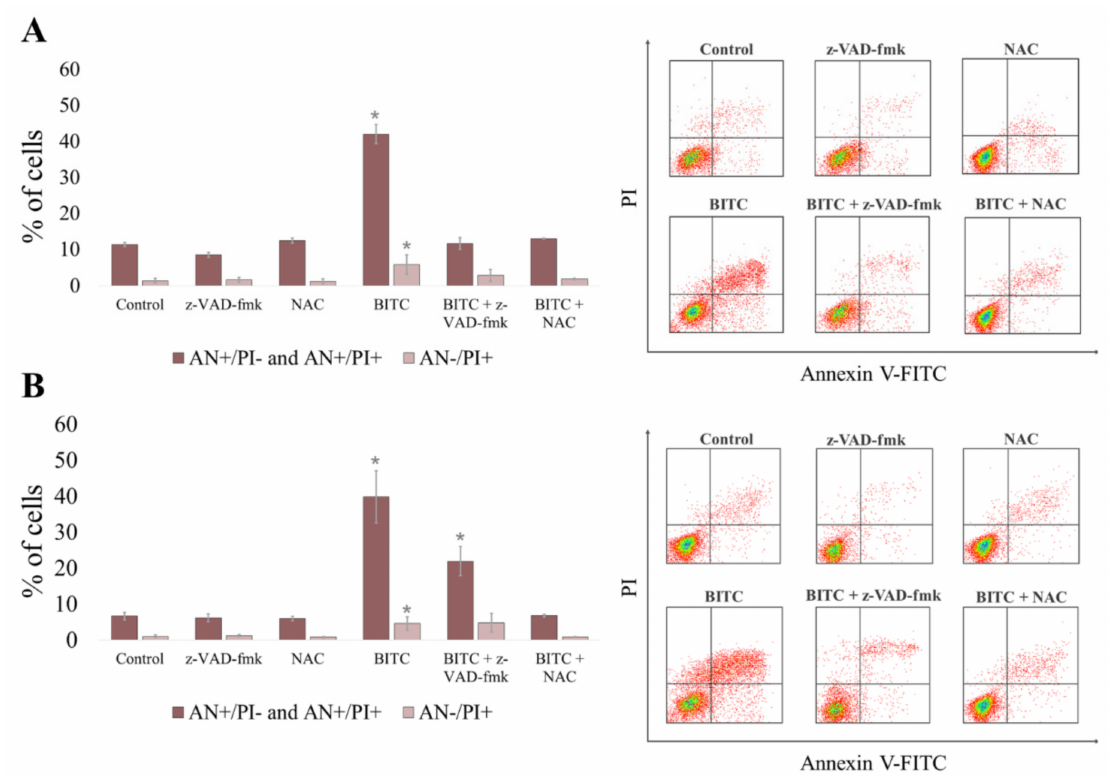
Figure 3. Apoptosis induced by BITC in CLB70 and CLBL-1 cell lines. CLB70 ( A ) and CLBL-1 ( B ) cells were incubated for 16 h with BITC (4 µ M) and the number of cells stained with Annexin V-FITC/PI was measured in flow cytometric analysis. The values are means ± SD of three independent experiments. * Considered significant in comparison with control ( p <